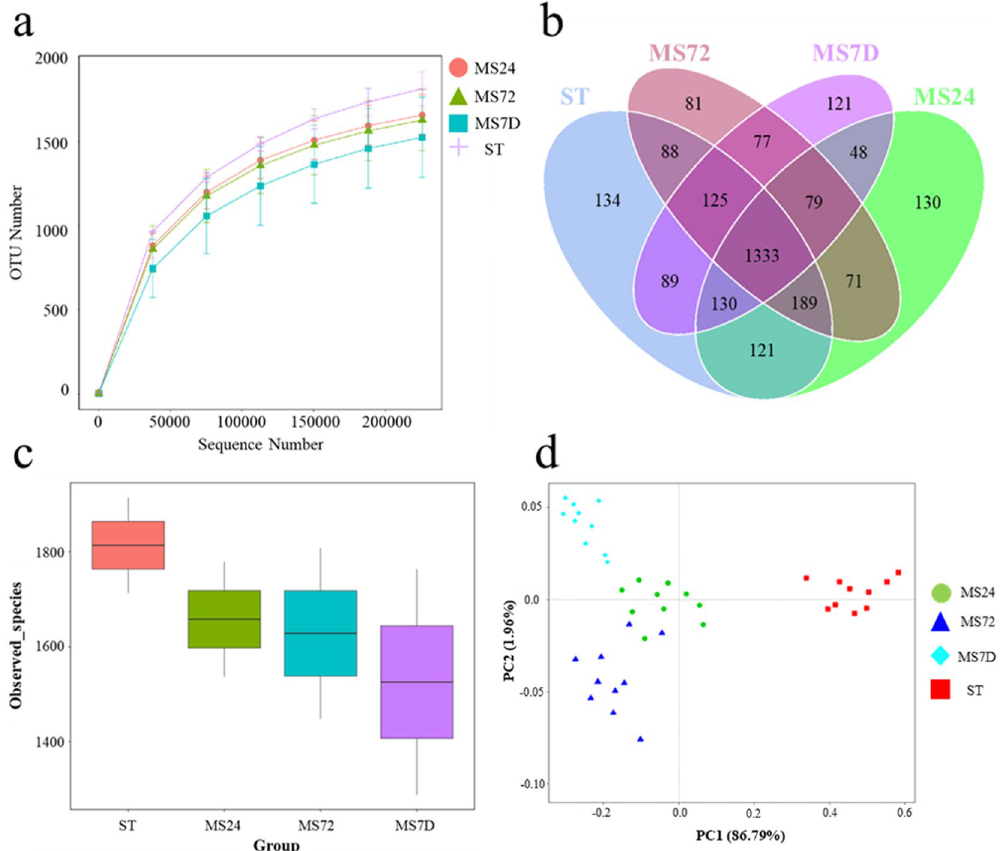
Figure 5. Metagenomic analysis of the fecal microbiota and of the microbial populations after incubation on the scaffolds. (a) Rarefaction curves for OTU number in the fecal microbiota (ST) and in those cultured on the electrospun gelatin structures (24 h: MS24; 72 h: MS72; 7 d: MS7D); (b) Venn diagram shows the number of shared OTUs between the fecal microbiota (ST) and the cultured ones at different times (24 h: MS24; 72 h: MS72; 7 d: MS7D) by the overlap; (c) comparison of the observed microbial species between the fecal microbiota (ST) and after incubation (24 h: MS24; 72 h: MS72; 7 d: MS7D) on the electrospun gelatin structures; (d) Principal coordinates analysis (PCoA) visualization of the weighted Unifrac distances between the microbial